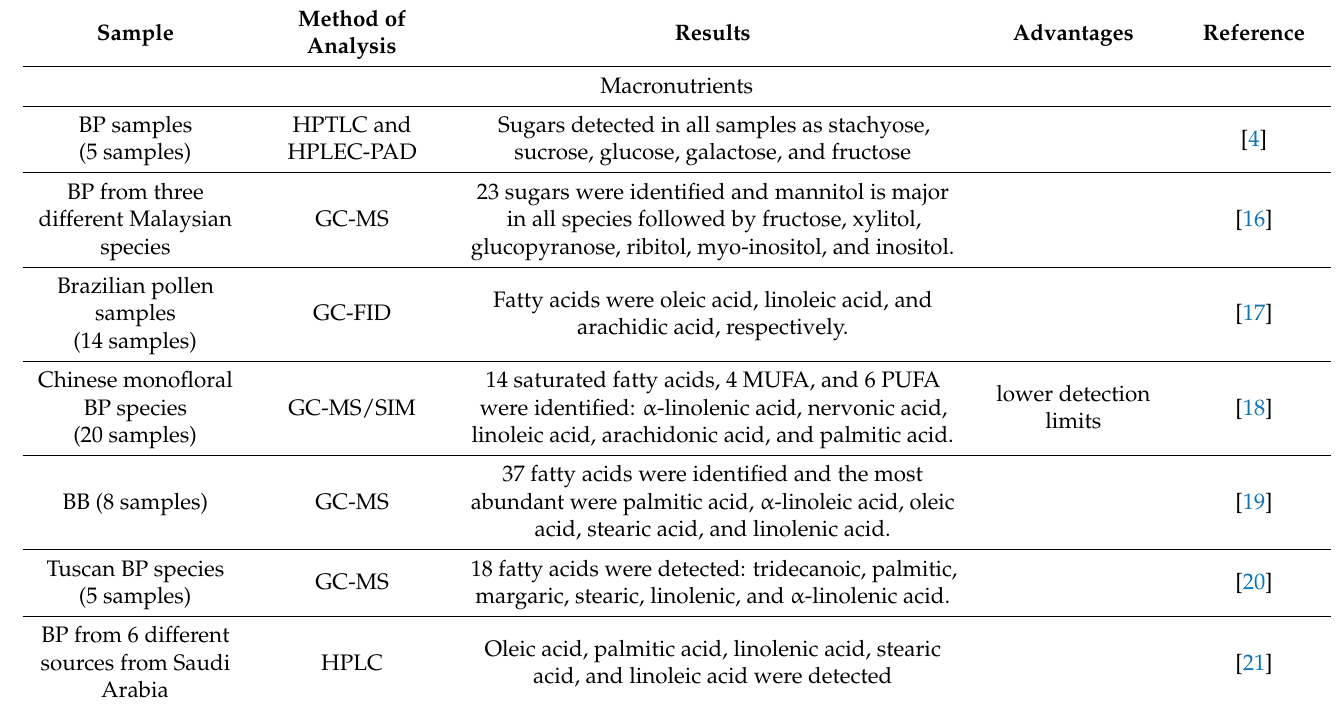
Table 1. Different analytical methodologies used for the analysis of BP and BB samples for macro-, micro-, and